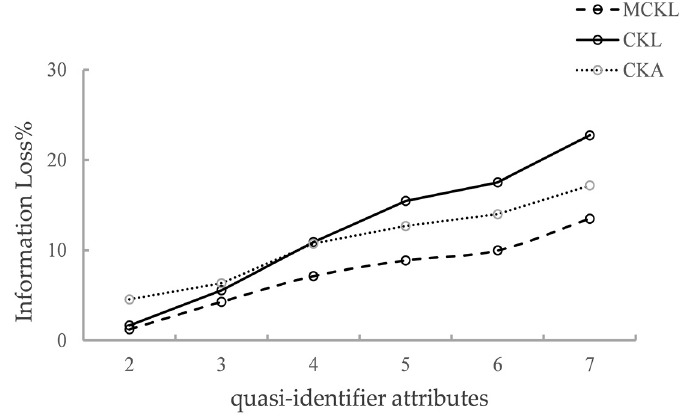
Figure 2. Information loss with a larger quantity of QI attributes.